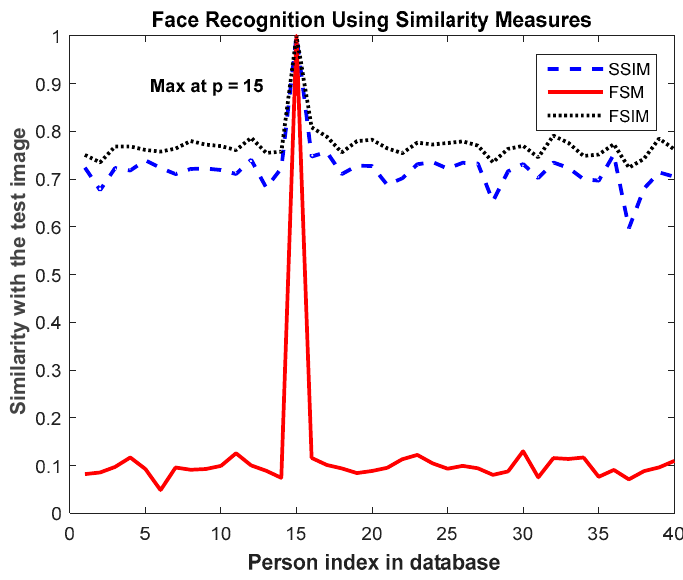
Figure 10. Performance of similarity measures using person No. 15 (pose 8) in the FEI database. Confidence in recognition for SSIM, FSIM and FSM is 0.2430, 0.1916 and 0.8697 respectively.